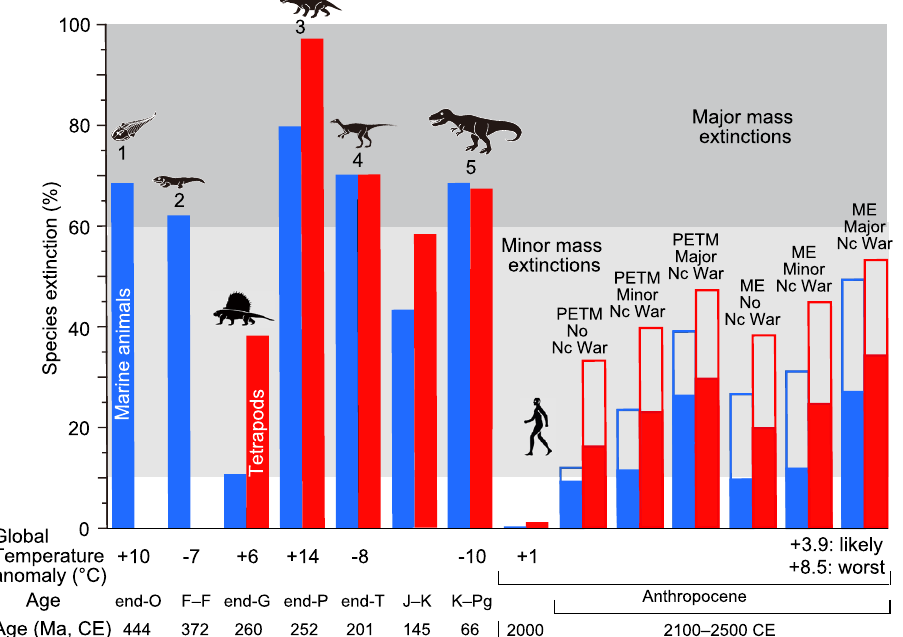
Figure 5. Marine animal and terrestrial tetrapod species extinction percentages corresponding to major and selected minor mass extinctions in the Phanerozoic with coincident global surface temperature anomalies. Numbers 1 to 5: the five major mass extinctions. Marine species extinction values in geologic ages shown by blue columns based on Bambach 20 . Terrestrial tetrapod species extinction values in geologic ages shown by red columns based on Benton et al. 32 and Sahney and Benton 21 . These extinction % data are comparable because of the usage of similar methods (conventional method and substage or substage-like short intervals) 4 . Closed bars in the Anthropocene show species extinction rate (%) in the case of the most likely case. Closed plus open bars in the Anthropocene show that in the case of the worst case. Global temperature anomaly: Global